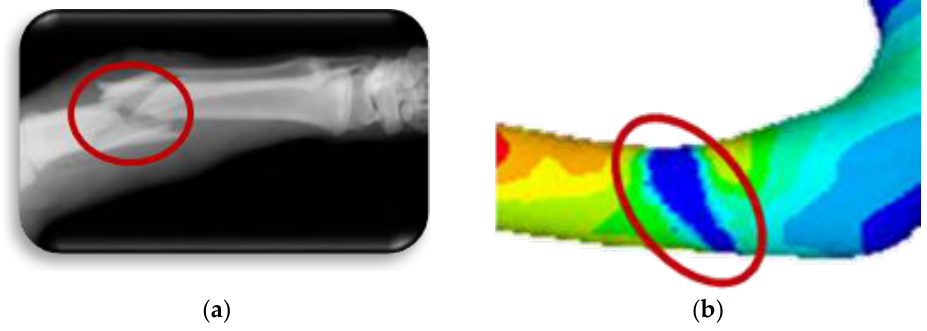
Figure 16. Comminuted fracture: ( a ) medical image of bone fracture; ( b ) fracture of finite elements generated on the model.